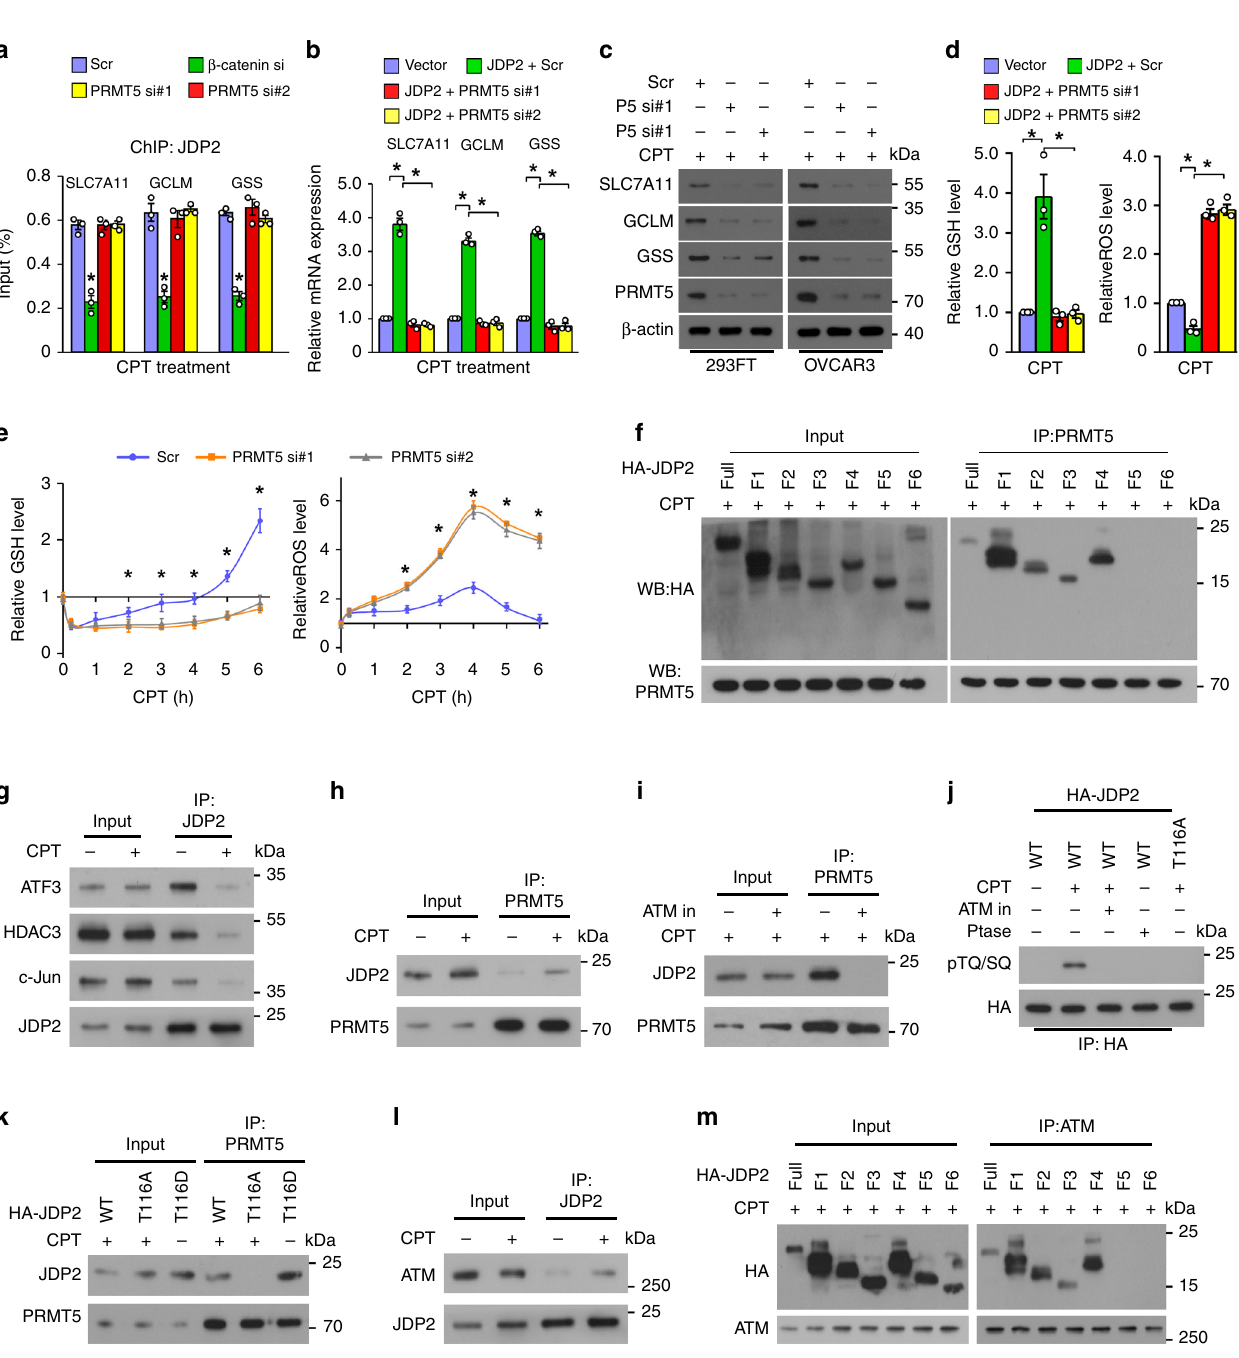
Fig. 5 PRMT5 promotes β -catenin/JDP2-activated glutathione metabolism. a , b The ChIP assay and qRT-PCR analysis of the enrichment of JDP2 on the promoters ( a ) and mRNA expression ( b ) of SLC7A11 , GCLM , and GSS in CPT (10 μ M, 1 h)-treated cells. c IB analysis of protein expression of SLC7A11, GCLM, and GSS in the CPT (10 μ M, 4 h)-treated cells transfected with scramble or PRMT5 siRNA(s). d Relative expression levels of GSH (left) and ROS (right) in the indicated cells. e Relative expression of GSH (left) and ROS (right) were examined in the indicated cells. f Co-IP assays using anti-PRMT5 antibody were performed in the CPT (10 μ M, 1 h)-treated cells transfected with truncated JDP2 fragments (right). g IP assays using anti-JDP2 antibody were performed in the indicated cells treated with or without CPT (10 μ M, 1 h), and IB analysis of the expression of JDP2, AFT3, c-Jun, and HDAC3. h IP assays using anti-PRMT5 antibody were performed in the indicated cells treated with or without CPT (10 μ M, 1 h), and IB analysis of expression of JDP2 and PRMT5 was performed. i IP assays using anti-PRMT5 antibody were performed in indicated cells treated with CPT (10 μ M, 1 h) with or without the ATM inhibitor KU55933 (10 μ M, 1 h) pretreatment, and IB analysis of the expression of JDP2 and PRMT5. j IP/IB assays analysis of HA-tagged JDP2 and phosphorylation of TQ/SQ in the indicated cells. k IP assays using anti-PRMT5 antibody were performed in the indicated cells treated with or without CPT (10 μ M, 1 h), and IB analysis of JDP2 and PRMT5. l IP assays using anti-JDP2 antibody were performed in the indicated cells treated with or without CPT (10 μ M, 1 h), and IB analysis of JDP2 and ATM. m co-IP assays were performed using anti-ATM antibody in the CPT (10 μ M, 1 h)-treated cells transfected with truncated JDP2 fragments. Each error bar in panels a , b , d , and e represents the mean ± SD of three independent experiments. * P < 0.05. Student ’ s two-tailed t test. Source data of Fig. 5a, b, d – e are provided as a Source Data fi